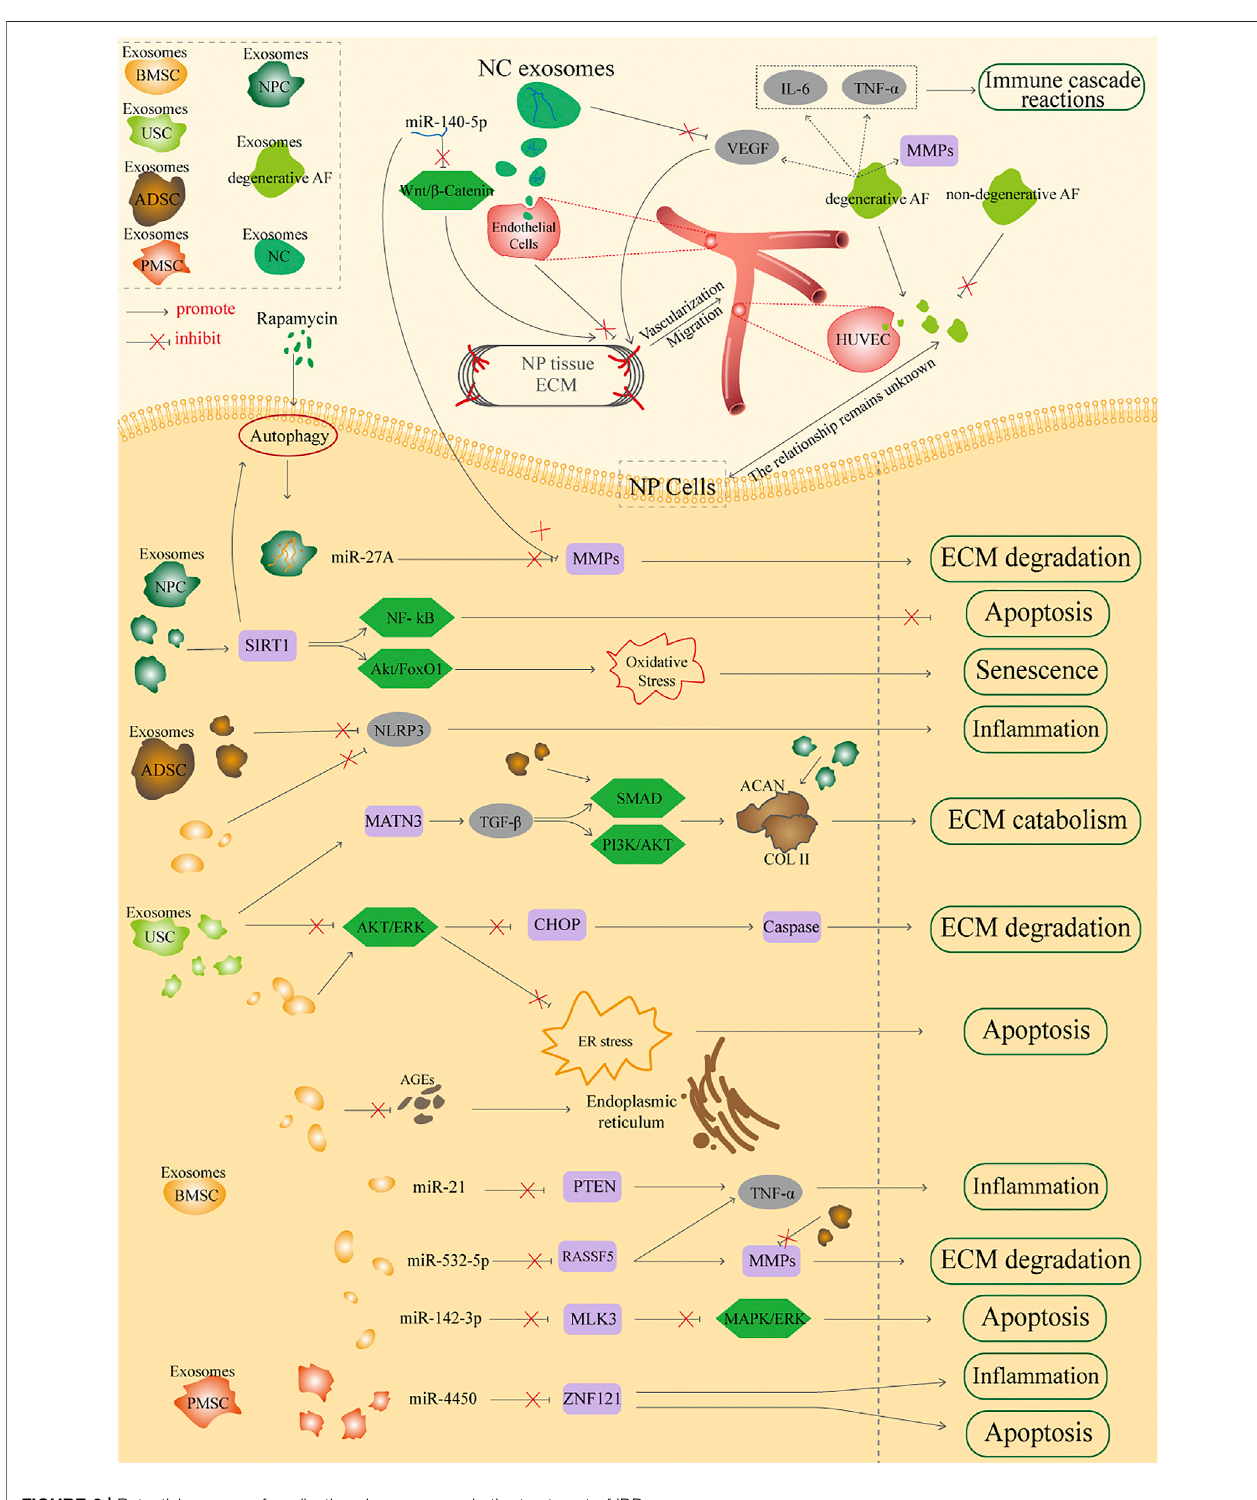
FIGURE 2 | Potential sources of applications by exosomes in the treatment of IDD.